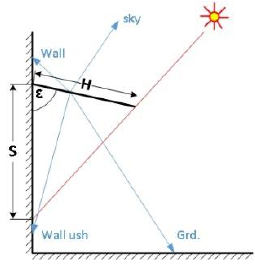
Figure 16. View factor to sky, wall and ground.